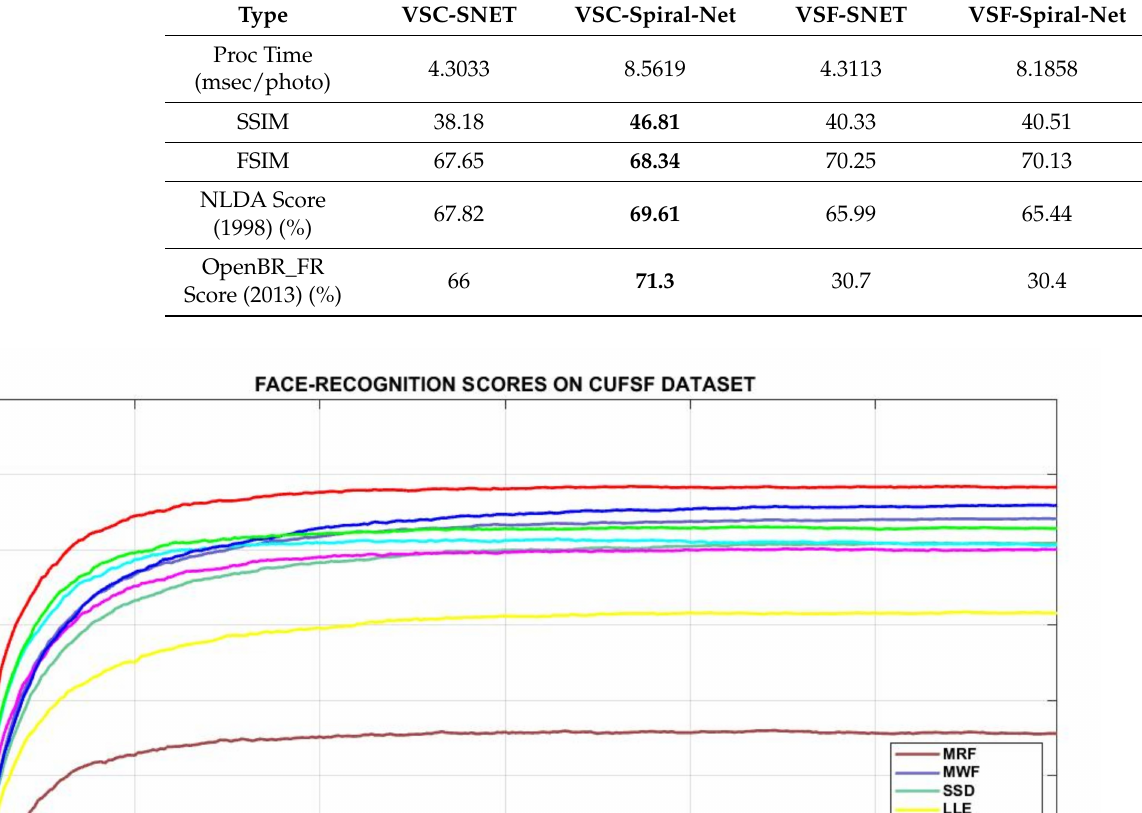
Table 9. Comparative values of performance for augmented datasets using SNET and proposed Spiral-Net.